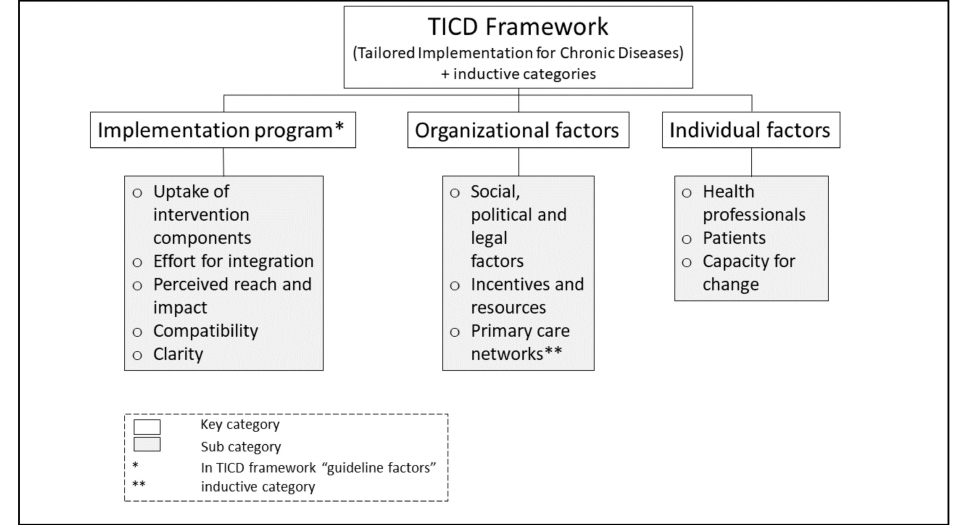
Figure 2. Analytical approach based on the Tailored Implementation for Chronic Disease (TICD)